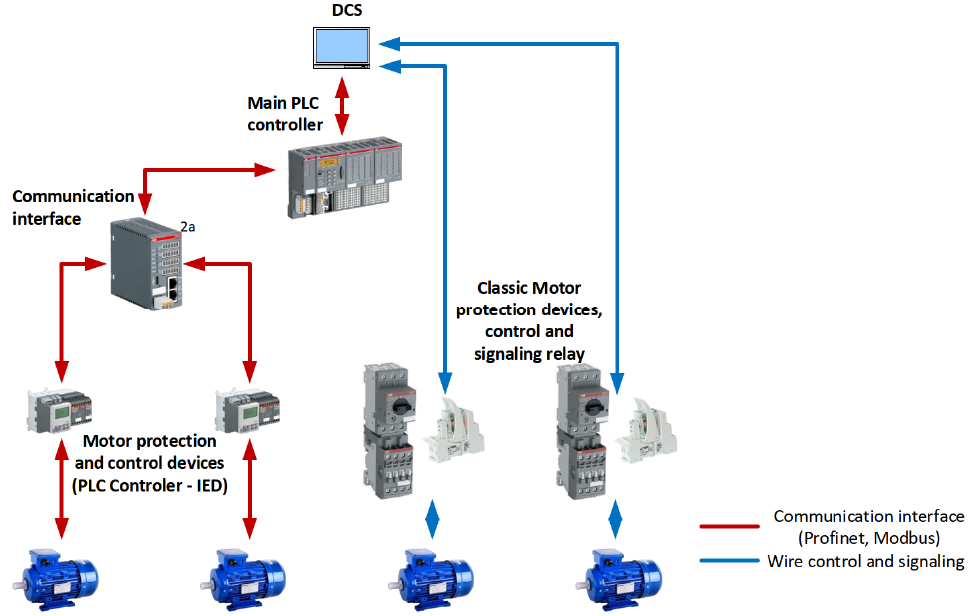
Figure 10. Hybrid solution.